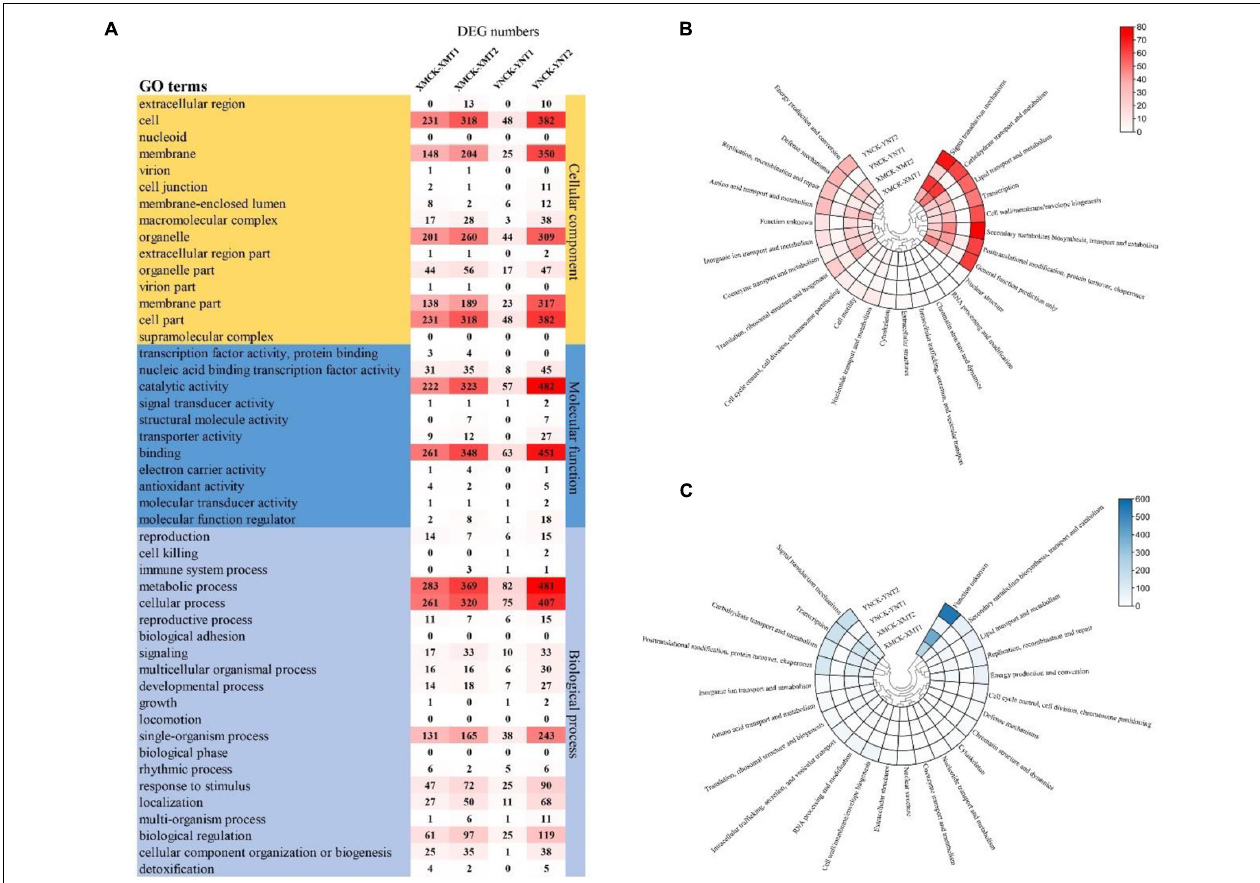
FIGURE 4 | (A) The number of DEGs for GO terms in each comparison group, (B) Heat map of clustering of the number of DEGs annotated by COG database, and (C) Heat map of clustering of the number of DEGs annotated by eggNOG database. XMCK, Xinmai26 was treated at 16 ◦ C; XMT1, Xinmai26 was treated at 4 ◦ C for 4 h; XMT2, Xinmai26 was treated at − 4 ◦ C for 4 h; YNCK, Yannong19 was treated at 16 ◦ C; YNT1, Yannong19 was treated at 4 ◦ C for 4 h; YNT2, Yannong19 was treated at − 4 ◦ C for 4